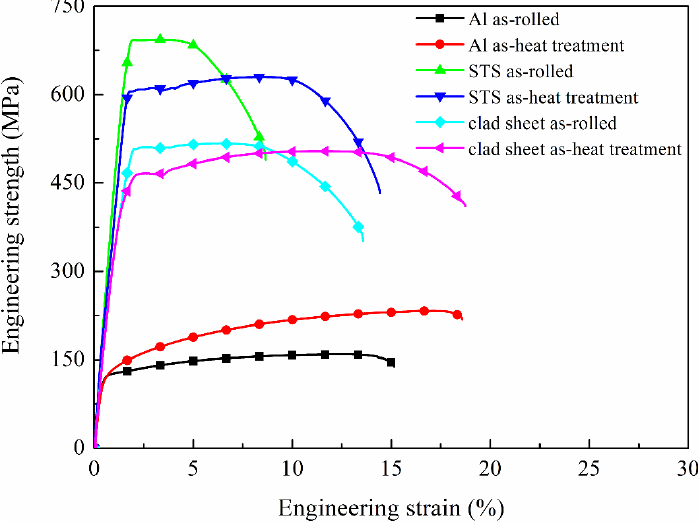
Figure 8. Engineering stress–strain curves for individual sheets and Al/steel composites.